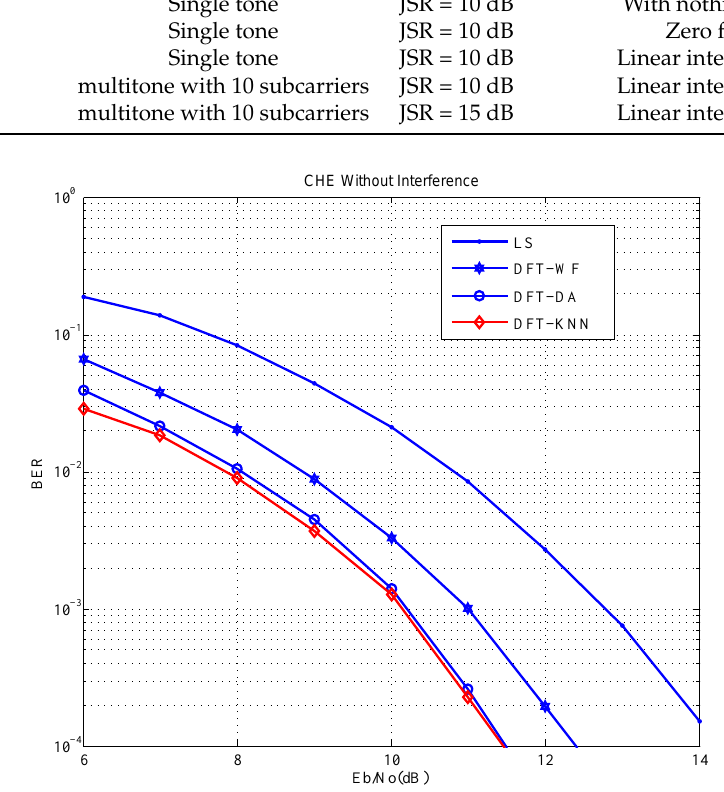
Figure 4. BER based on different channel estimation